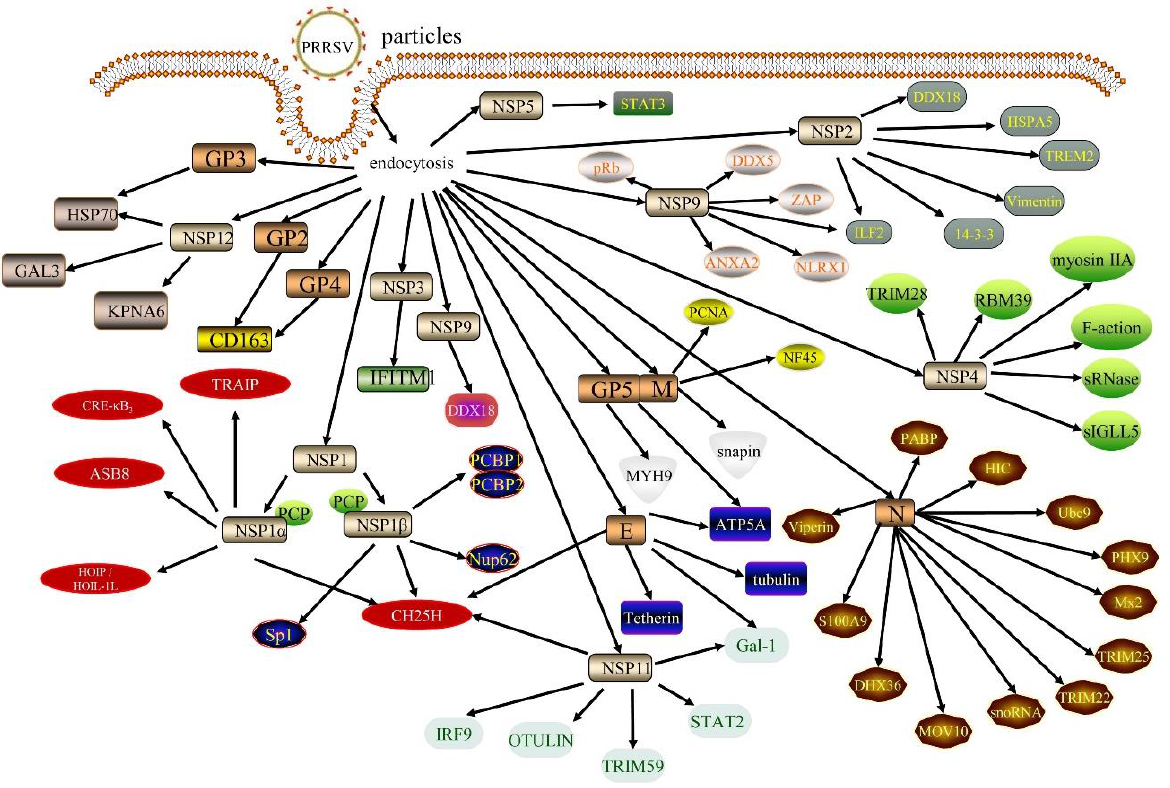
Figure 1. The interactions of the structural proteins of PRRSV and nonstructural proteins with host proteins mentioned in the article.